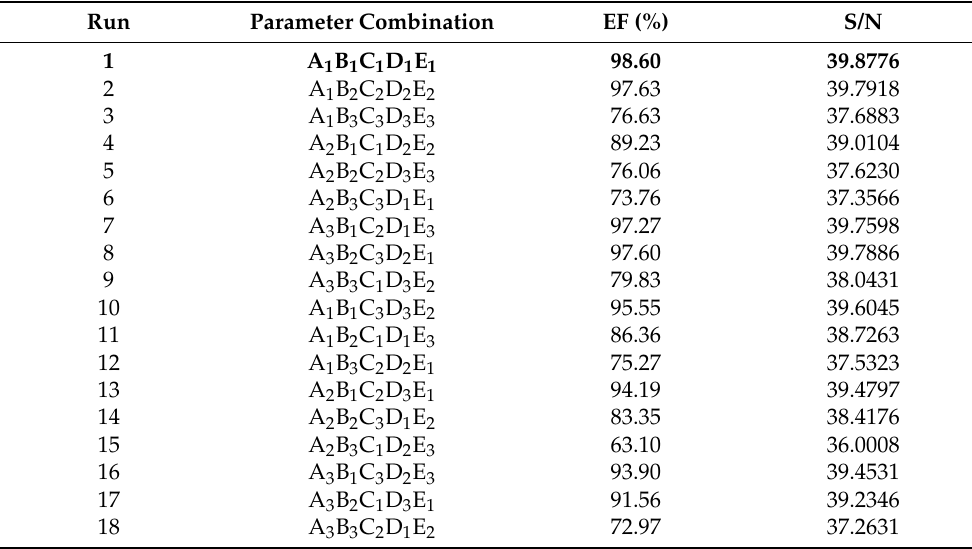
Table 4. Flocculation efficiency results using the Taguchi L 18 orthogonal array during the flocculation of the Bacillus sp. BioSol021 cultivation broth.